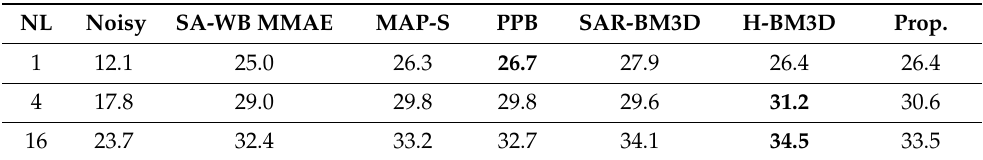
Table 5. Image Lena. PSNR [dB] performance of different despeckling systems: results reported in [49]: MAP-S; results reported in [53]: SA-WBMMAE, PPB, SAR-BM3D, H-BM3D; and results of proposed